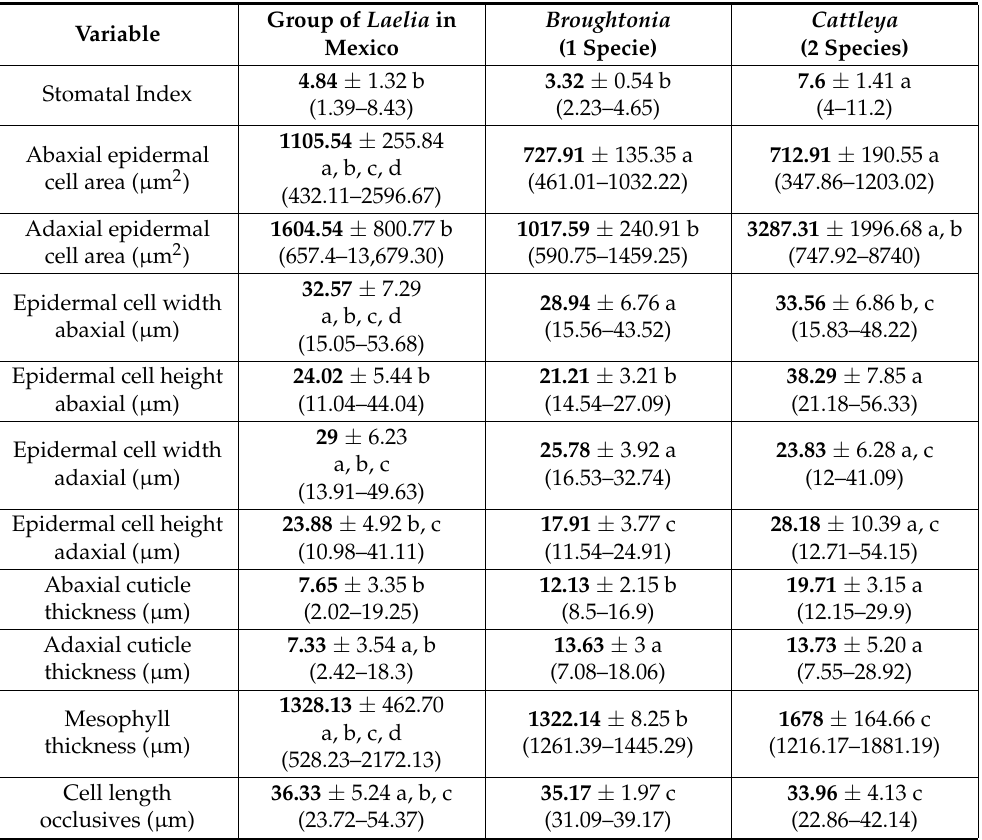
Table 1. Descriptive statistical data of the continuous quantitative characters of the 15 species analyzed in this study: Laelia in Mexico, Broughtonia and Cattleya . Numbers in bold indicate means, ± one standard deviation (SD); each letter represents a group, according to Dunnett’s post hoc analysis. Values indicate the mean, standard deviation, and (minimum and maximum) indicate the interval.